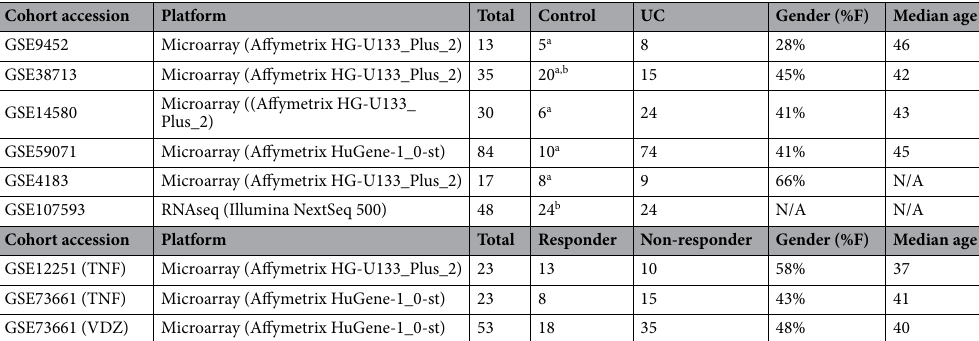
Table 3. Clinical and demographic characteristics of UC patients included in analysis. a Healthy control. b Uninflamed matched control from UC